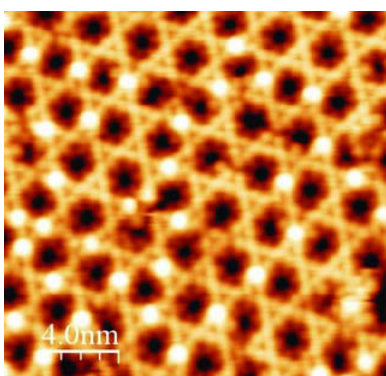
Figure 3 – Complete filling of the silicon surface when indium is sprayed onto the surface Рис . 3 – Полное заполнение поверхности кремния при напылении